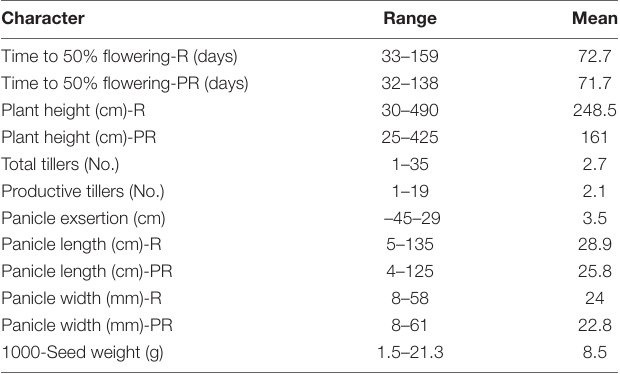
TABLE 1 | Range of variation in pearl millet germplasm